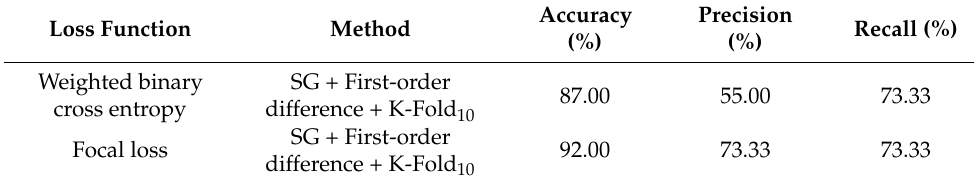
Table 6. Comparison of DNN.